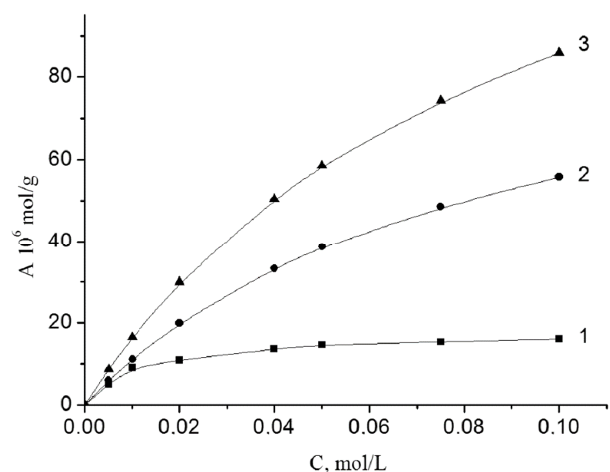
Figure 1. Isotherms of BP adsorption from styrene on the surface of iron (1), chromium (2) and vanadium (3) oxides at 303 K. The content of oxides was 1 g/L. The adsorption-desorption equilibrium was established in 10–15 min. The parameters of the adsorption process are show in Table 1.